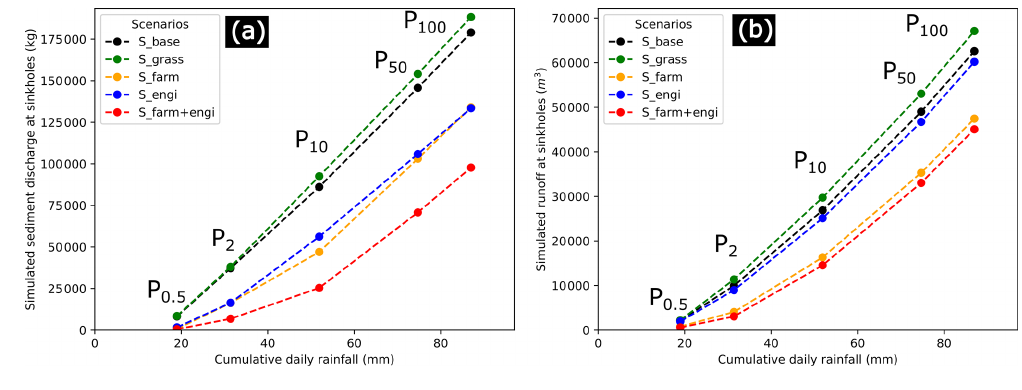
Figure 7. WaterSed modelling results according to the five designed storms for the four scenarios: simulated (a) sediment discharge (kg) and (b) runoff (m 3 ), extracted and summed over the seven connected sinkholes on the Radicatel catchment (S_base: baseline scenario in 2018; S_grass: 33% of grasslands ploughed up; S_farm: + 15% infiltration capacity on 50% of the plots; S_engi: implementation of 181 fascines and 13.1ha of grass strips; S_farm + engi: combination of S_farm and S_engi).